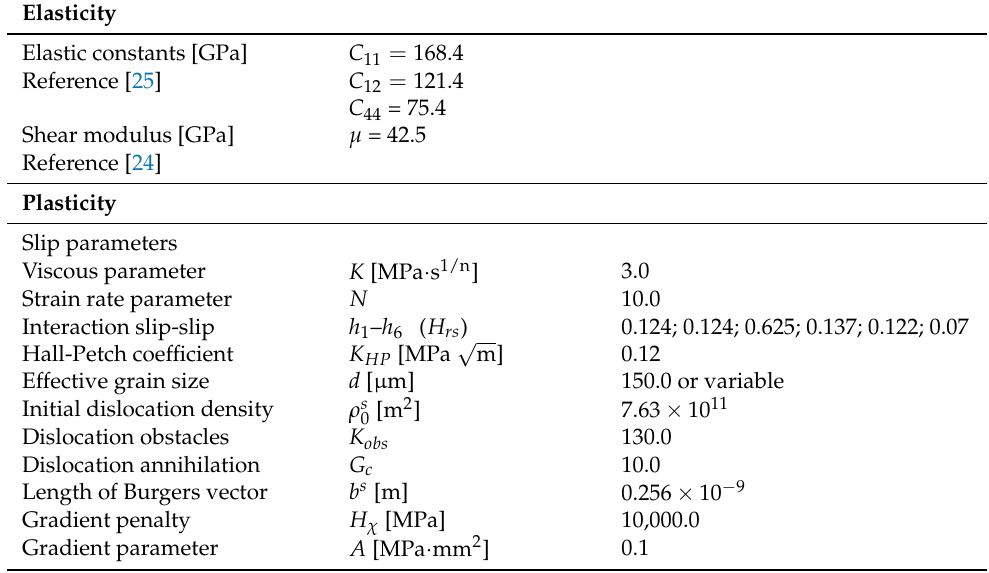
Table 1. Crystal plasticity model